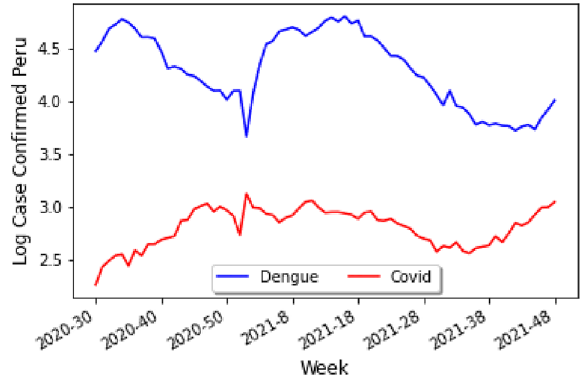
Figure 5. Weekly correlations between COVID-19 and dengue for Perú.